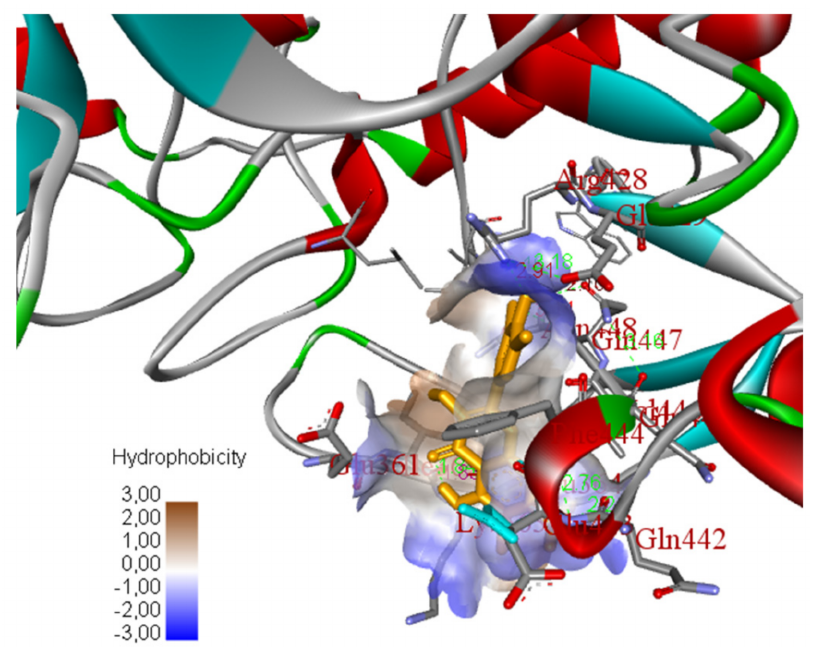
Figure 3. The most stable conformation ligand 11 was docked to active sites of enzyme and pocket enzyme of 4J5T: PDB (ligand: brown